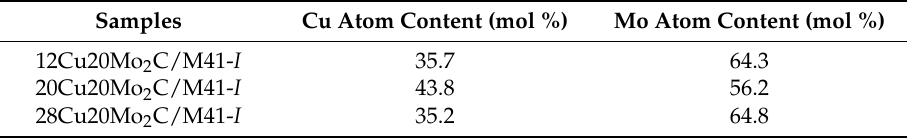
Table 3. Surface Cu and Mo atom content of the x Cu20Mo 2 C/M41- I samples.